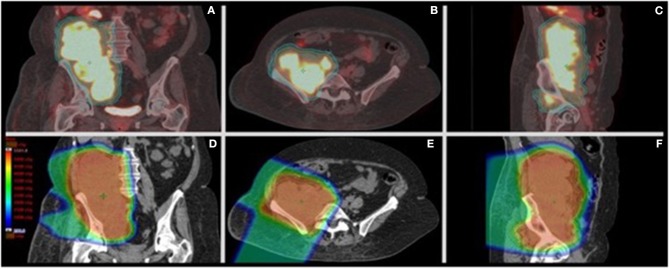
PET/CT of the primary retroperitoneal sarcoma with palliative proton radiotherapy plan dose distribution. (A–C) Representative coronal, axial, and sagittal images from the CT simulation for radiation treatment planning fused to the staging PET scan showing the clinical target volume (CTV-orange) and planning target volume (PTV-aqua) encompassing the right retroperitoneal FDG-avid disease. The CTV encompassed the FDG-avid sites of disease with a 0.5 cm expansion to create the PTV. (D–F) Representative coronal, axial, and sagittal images from the radiation treatment plan showing the dose color wash from right anterior and right posterior oblique beams. Dose color wash ranges from 2 CGE (dark blue) to >50 CGE (red) without significant exit dose beyond the 2 CGE isodose. Treatment was delivered using right anterior oblique and right posterior oblique passively scattered proton beams from a MEVION S250 unit.